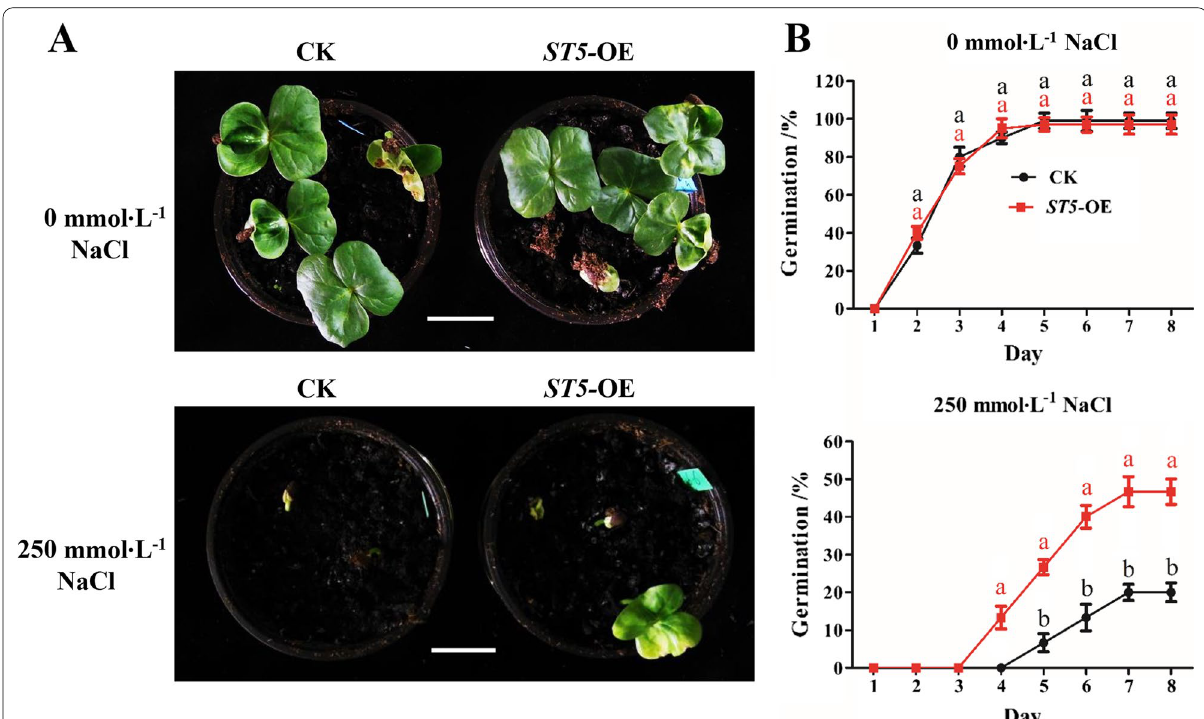
Fig. 1 Overexpression of ThST5 significantly improves salt tolerance in cotton. A Seed germination of wild type control (CK) and ST5 overexpression line ( ST5 -OE) under water or 250 mmol L − 1 NaCl for two weeks. Photographs were taken at the 8th day after sowing. Bar 4 cm. B Germination · = rate of transgenic seeds and CK in water or 250 mmol L − 1 salt treatment. Values are mean SD (standard deviation) of three biological replicates. · ± Different letters represent significant difference ( P < 0.05) as calculated by Duncan’s multiple range